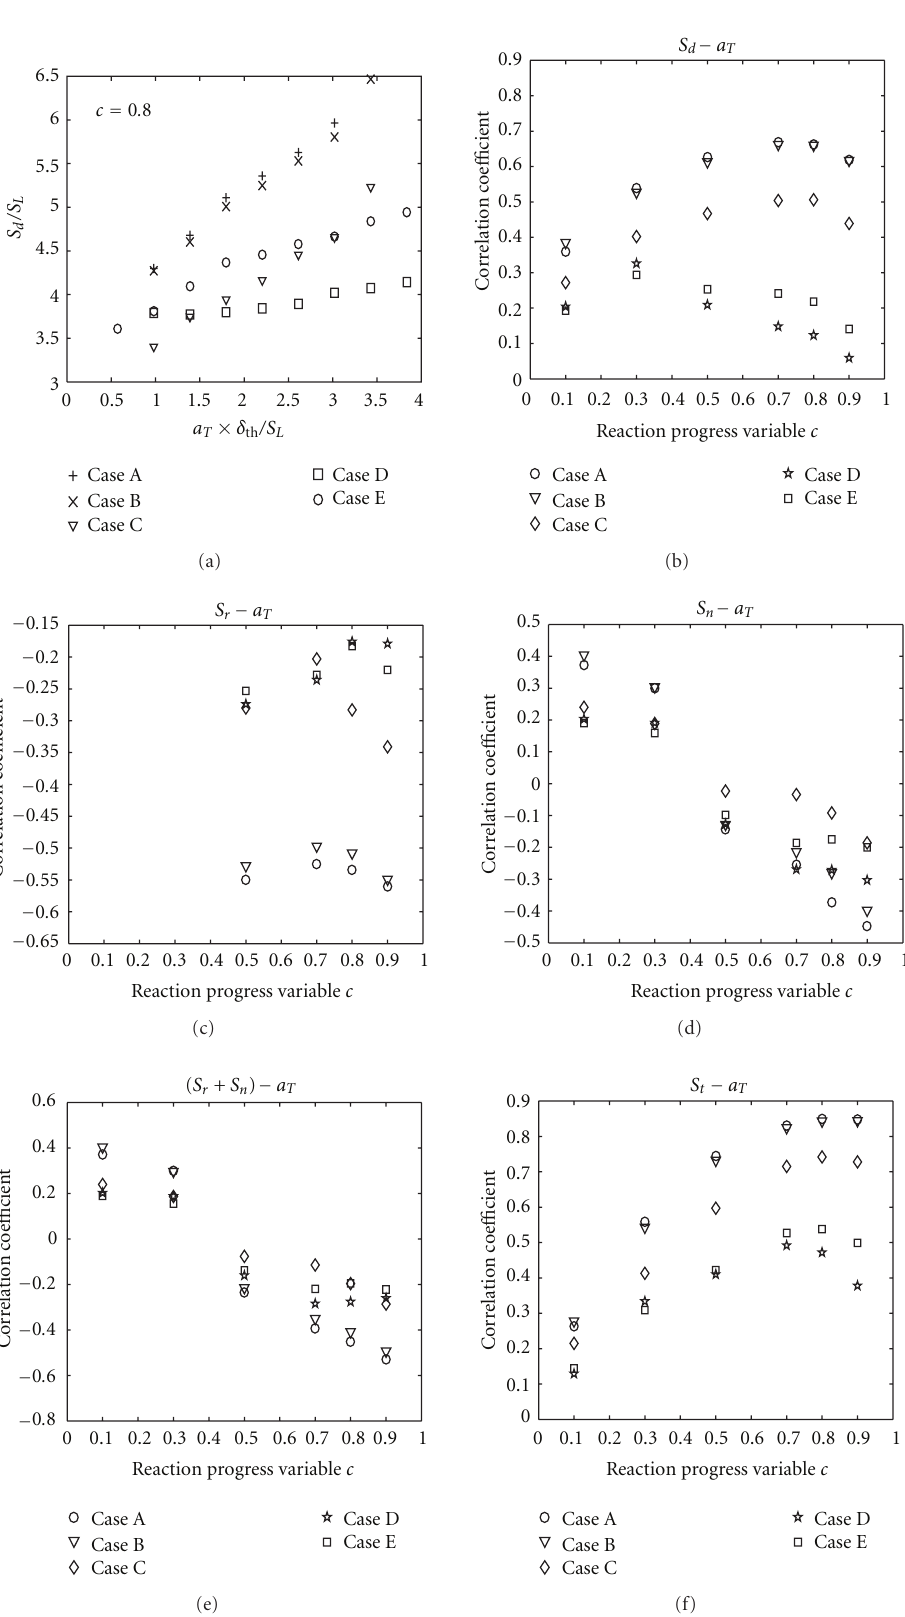
Figure 11: (a) Variation of mean values of S d /S L conditional on normalised tangential strain rate a T × δ th /S L for the isosurface at c = 0.8. Variation of the correlation coe ffi cients for all cases on the di ff erent c isosurfaces among (b) S d and a T , (c) S r and a T , (d) S n and a T , (e) ( S r + S n ) and a T and (f) S t and a T